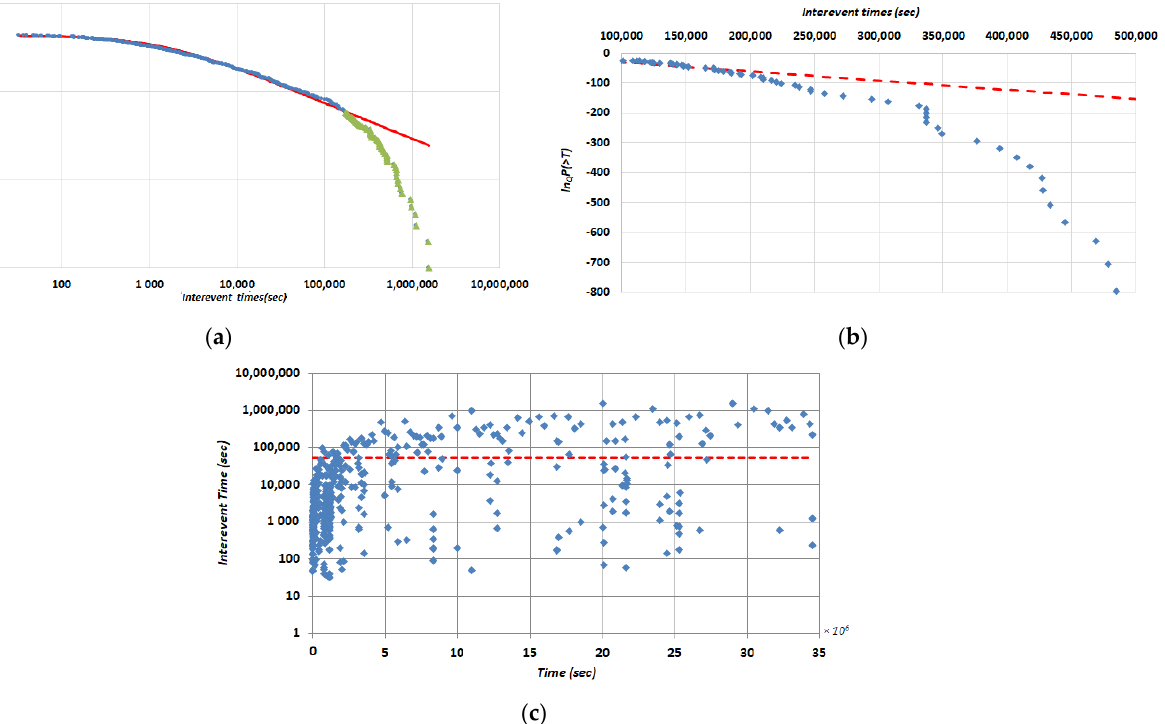
Figure 6. ( a ) The interevent times CDF of the 2019 M w 5.1 Parnitha Earthquake, for the aftershocks with M > M c . The scarlet stroke is the Q -exponential fitting with q = 1.71. The change of colors indicates the crossover between the NESP (blue circles) and BG statistics (green triangles). ( b ) The ln Q P (> T ) as a function of T , where the red line is the fitting with q = 1.71 and correlation coefficient 0.9912 up to T c . T c value close to 175,460 s is suggested by the deviation from linearity. ( c ) Interevent time T evolution with time t since the main shock. The scarlet line illustrates the T c value.